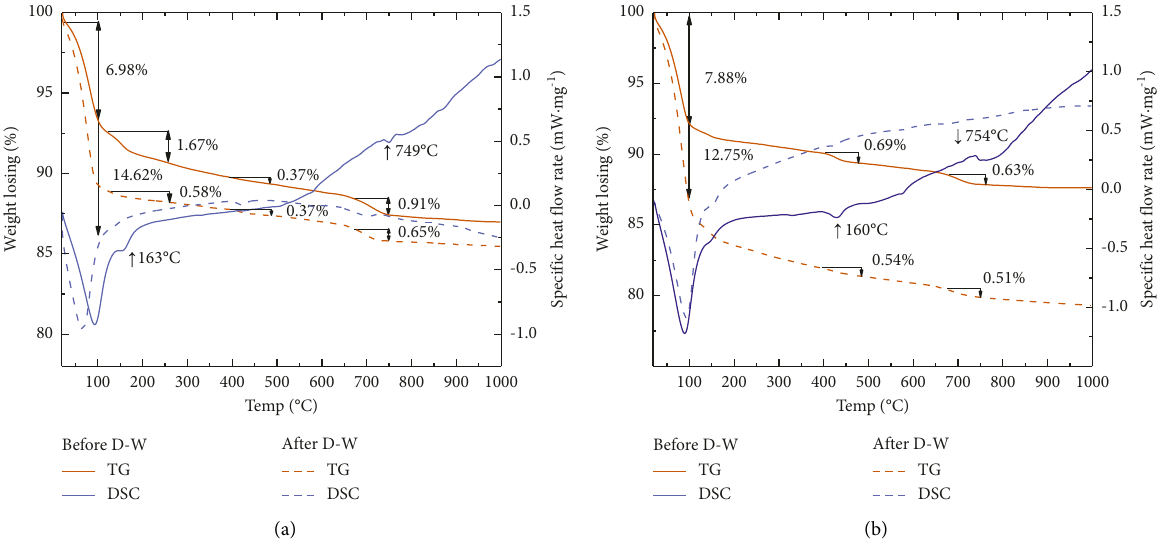
Figure 12: TG-DSC chart of 8% L +4% MK and 10% NHL-modified soil before and after dry-wet cycle. (a) 8% L +4% MK. (b) 10% NHL. Table 3: Calculation results of CSH, Ca(OH)